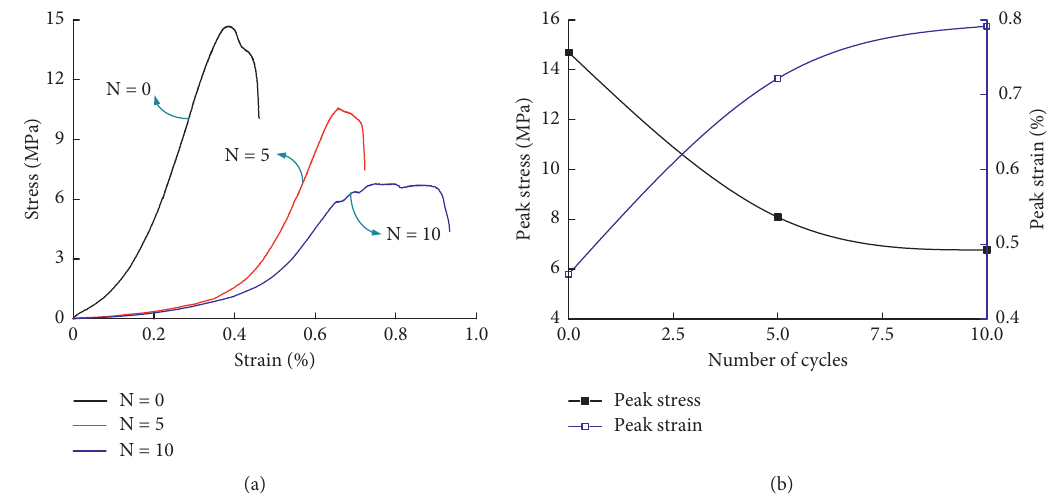
Figure 6: Uniaxial stress-strain curves of the WCST specimens under different numbers of dry-wet cycles. (a) Stress-strain curves. (b) Peak stress and peak